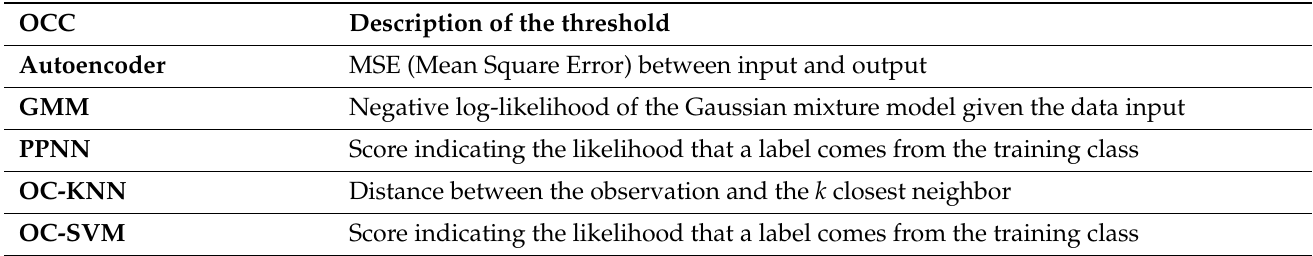
Table 4. Decision thresholds employed to detect anomalies for the five considered OCCs.